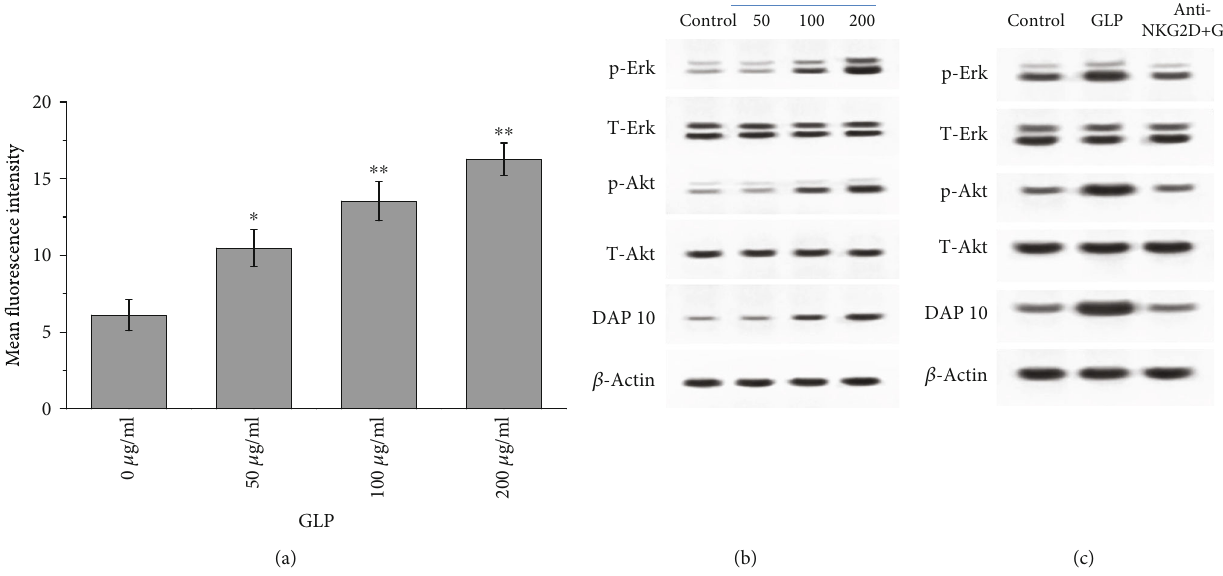
Figure 4: GLP activated NK-92 cells via the NKG2D pathway. (a) GLP enhanced the expression of NKG2D on NK-92 cells in a dose- dependent manner. Compared with the untreated group, ∗ indicated p < 0 : 05 , ∗∗ indicated p < 0 : 05 . (b) GLP enhanced the phosphorylation levels of Akt and erk and the expression level of DAP10 protein in NK-92 cells. (c) Enhanced phosphorylation level of Akt and erk and the expression level of DAP10 protein in NK-92 cells by GLP treatment were reduced by silencing NKG2D in NK-92 cells with NKG2D